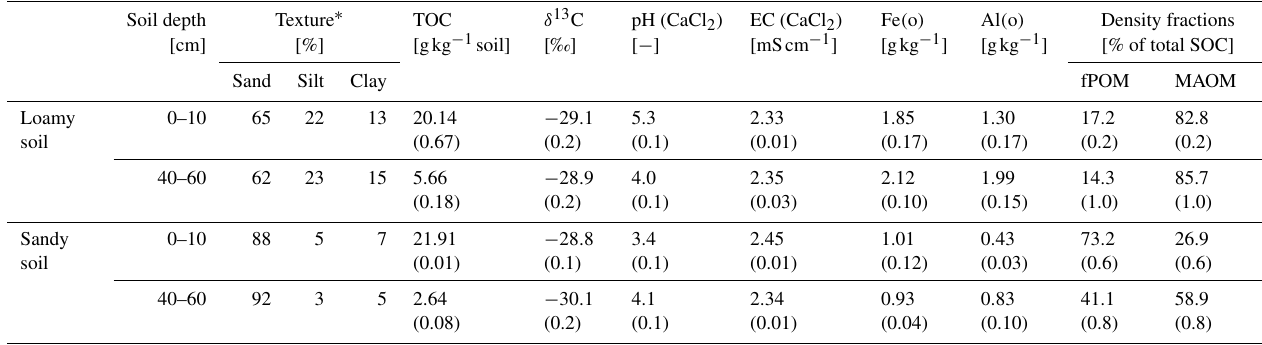
Table 1. Soil texture, total organic carbon (TOC), δ 13 C, pH, electrical conductivity (EC), oxalate-extractable Fe ( o ) and Al ( o ) , and density fractions (free particulate organic matter, fPOM; and mineral-associated organic matter, MAOM) for the topsoil (0–10cm depth) and subsoil (40–60cm) of the loamy and sandy soil ( ± 1SE). See Sect. 2.4 for methods.